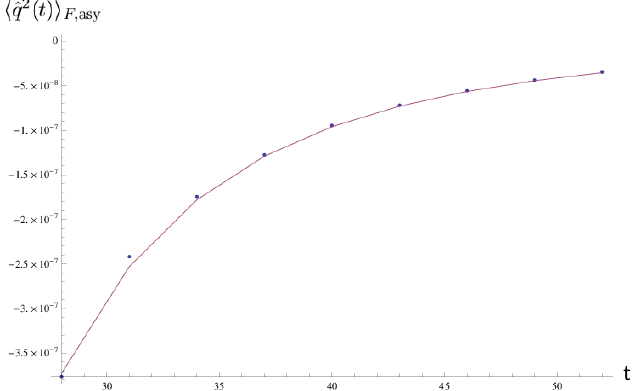
(cid:25)(cid:11) )(cid:1) 2 with the parameters 2 M(cid:25) (cid:10) 2 (cid:11)